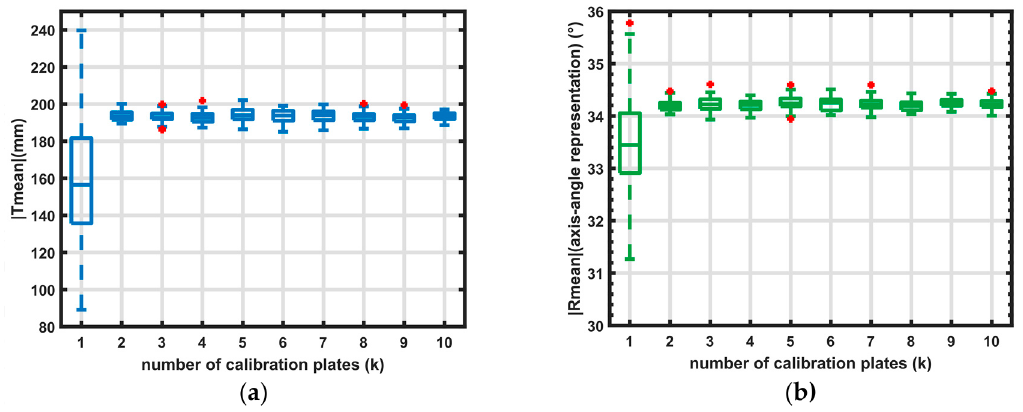
Figure 8. Boxplot of calibration. Each dataset is built from k calibration plates; the calibration is repeated 50 times with 100 random points. The bottom and top edges of the box indicate the 25th and 75th percentiles, respectively. The whiskers (dotted lines) extend to the most extreme data points (Translation or Rotation) that are not considered outliers. The outliers are plotted as a (red) plus symbol. ( a ) Visualisation of translation (Tmean) and ( b ) rotation angle (R mean ) (axis-angle